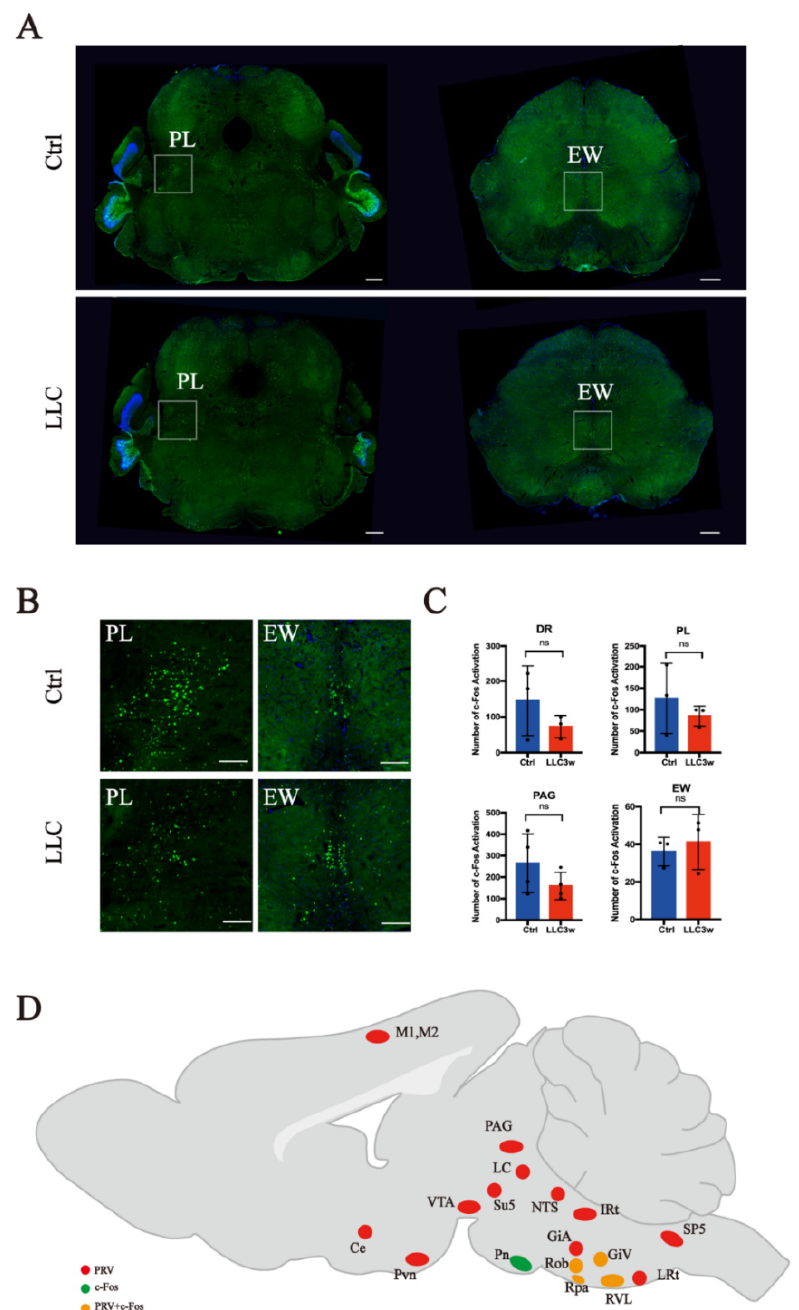
Figure 4. Overall c-Fos activation patterns in the midbrain. Schematic diagram of the overlap of PRV-positive and c-Fos-positive brain regions. ( A ) Overview of coronal sections in the midbrain of LLC and control mice (scale bar = 400 µ m). ( B ) Enlarged photomicrographs of the midbrain regions illustrate c-Fos activation in various brain structures of LLC and control mice (scale bar = 100 µ m). ( C ) Levels of c-Fos-activated neurons in LLC and control groups. There is no statically significant difference in DR, PL, PAG, and EW between the LLC group and the control group ( p > 0.05). DR = dorsal Raphe nucleus, PL = paralemniscal nucleus. ( D ) Schematic diagram PRV and c-Fos co-labeled brain regions. Red represents neurons retrogradely labeled with PRV, green represents neurons with changes in c-Fos activation in orthotopic lung cancer, and orange represents neurons co-labeled with c-Fos and PRV. “ns” represents no significant differences, red bars represent the experimental group (LLC3w) and blue bars represent the control group (Ctrl).